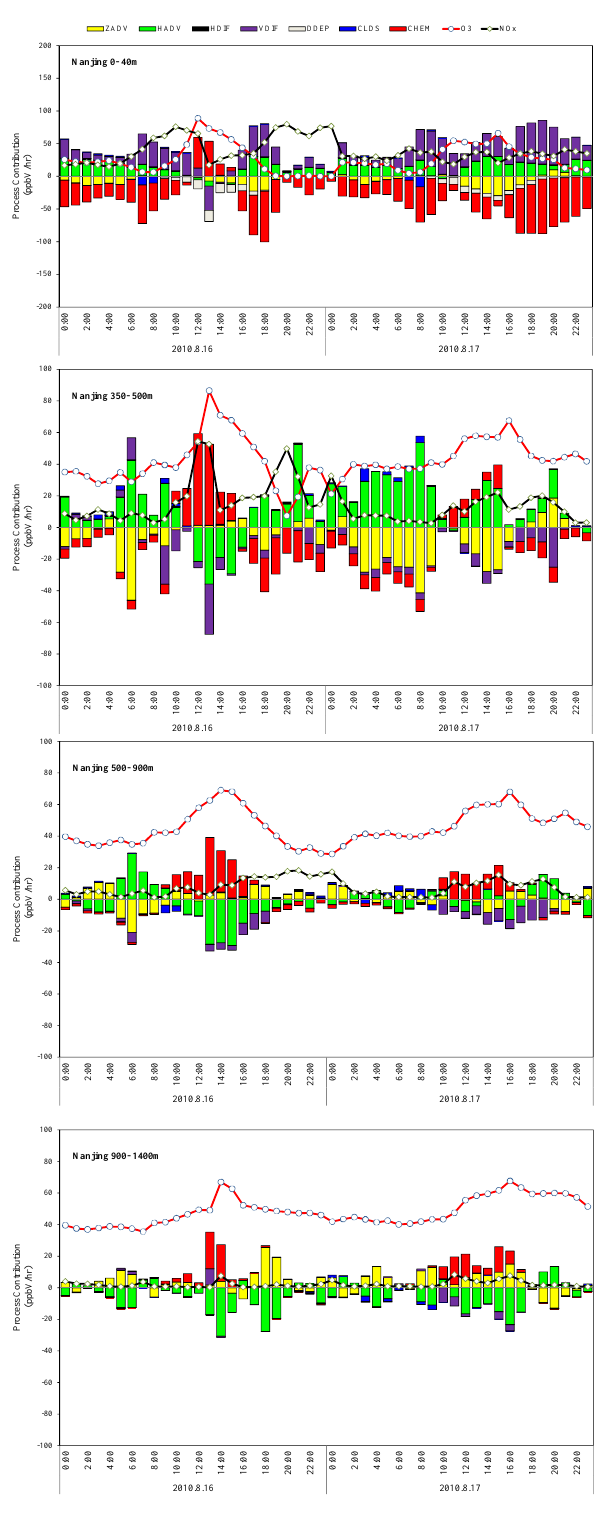
Fig.12. Atmospheric processes contribution to net O 3 density at Nanjing site during August 16--17, Fig. 12. Atmospheric processes contribution to net O 3 density at 2010. Nanjing site during 16–17 August Figure.10 shows the emission inputs of NO x and main VOC species at the Nanjing site. As shown in the figure, the NO x emissions from both traffic and industries are high, and the VOC emissions, especially the terminal olefin carbon bond (OLE) emissions, are also quite high due to both vehicles and the Jinling petrochemical company. Therefore, the O 3 precursor emissions at the Nanjing site are much higher than at the other sites, so the positive contribution to O 3 from gas-phase chemistry is high, and the highest O 3 mixing ratio at the Nanjing site reached 86.5 ppb.